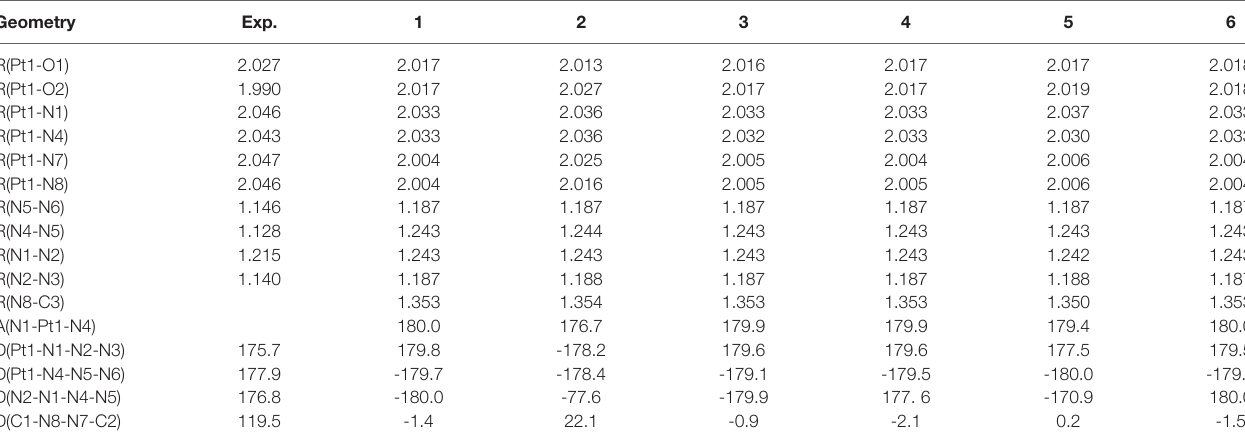
TABLE 2 | Optimized bond length(in Å) and bond angle(in deg) of compounds 1, 2, 3, 4, 5 and 6. Geometry